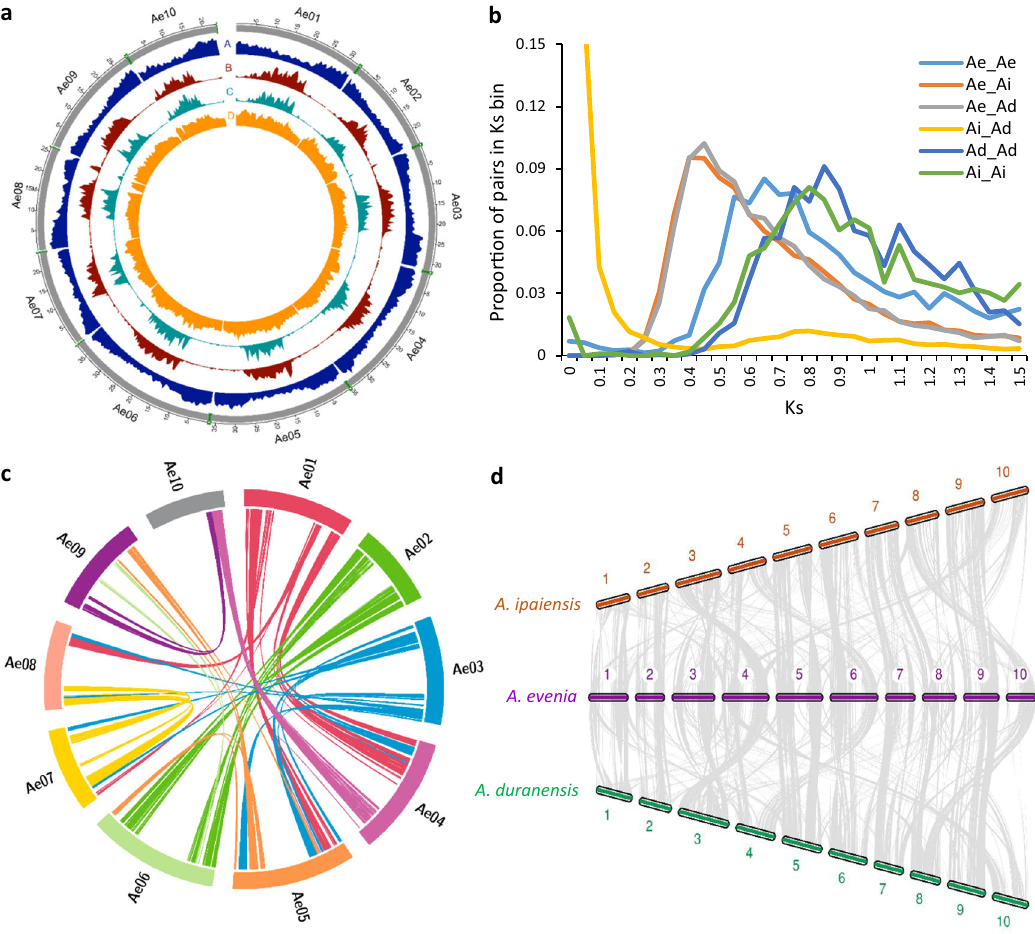
Fig. 1 Structure and evolution of the Aeschynomene evenia genome. a Distribution of genomic features along the chromosomes. The outer ring represents the 10 chromosomes with the captured telomeres in green (scale is in Mb). A, Gene density. B, density of transposable elements LTR/Copia. C, density of Gypsy transposable elements. D, Total SNP distribution. Densities are represented in 0.5 Mb bins. b Ks analysis of A. evenia (Ae) with the Arachis species, A. duranensis (Ad) and A. ipaiensis (Ai). Proportion of gene pairs per Ks range (with bin sizes of 0.05) for indicated species pairing. The shift of the WGD Ks peaks in Ae-Ae vs Ad-Ad and Ai-Ai is notable (0.65 vs 0.85 and 0.8), indicating more rapid accumulation of mutations in Arachis species than in A. evenia . c Syntenic regions in the A. evenia genome corresponding to intragenomic duplications. The colored lines are links between colinearity blocks that represent syntenic regions >1 Mb. d Syntenic relationships between A. evenia (center) and Arachis species, A. ipaiensis (upper) and A. duranensis (lower). The syntenic blocks >1 Mb in the A. evenia genome are shown. To facilitate comparisons, for Arachis species, chromosomes were scaled by factors calculated based on the genome size of A. evenia . Source data underlying ( b – d ) are provided as a Source Data fi